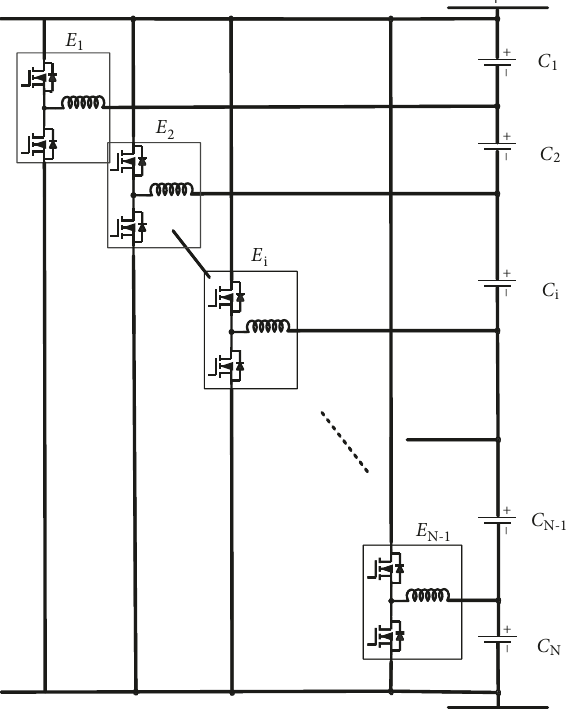
Figure 1: Topology of the BMMEEC.